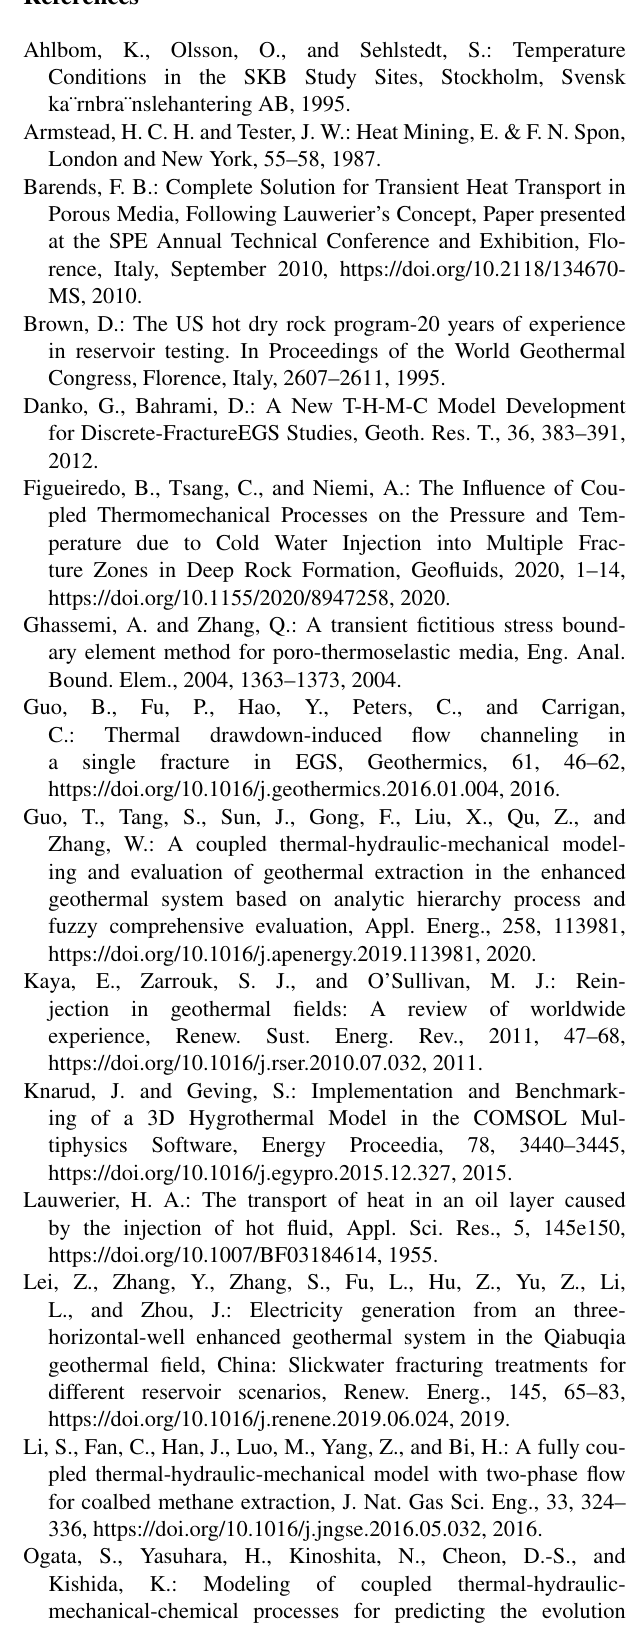
Figueiredo, B., Tsang, C., and Niemi, A.: The Influence of